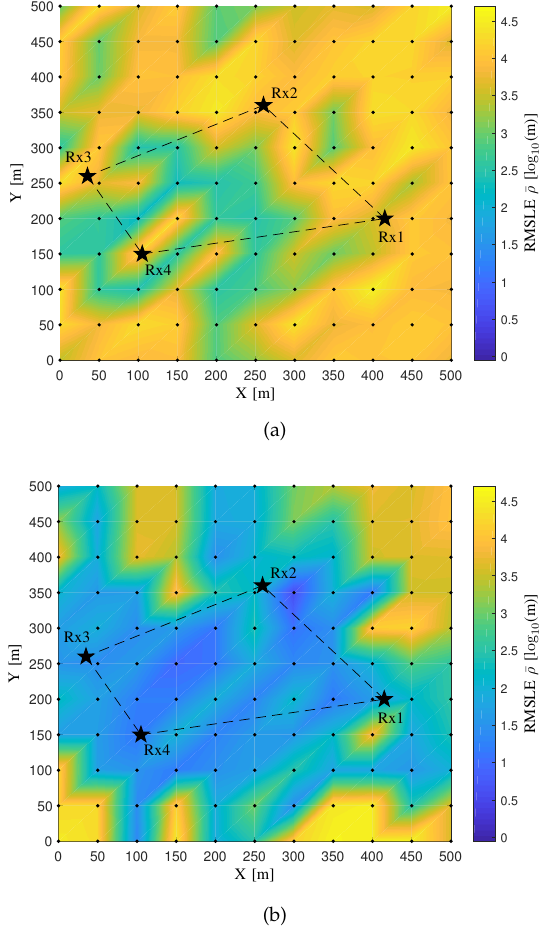
Figure 7. The comparison of the Root Mean Square Localization Error (RMSLE) heat map between two localization algorithms for the verification of the propagation graph simulation. ( a ) The Algorithm A; ( b ) The Algorithm